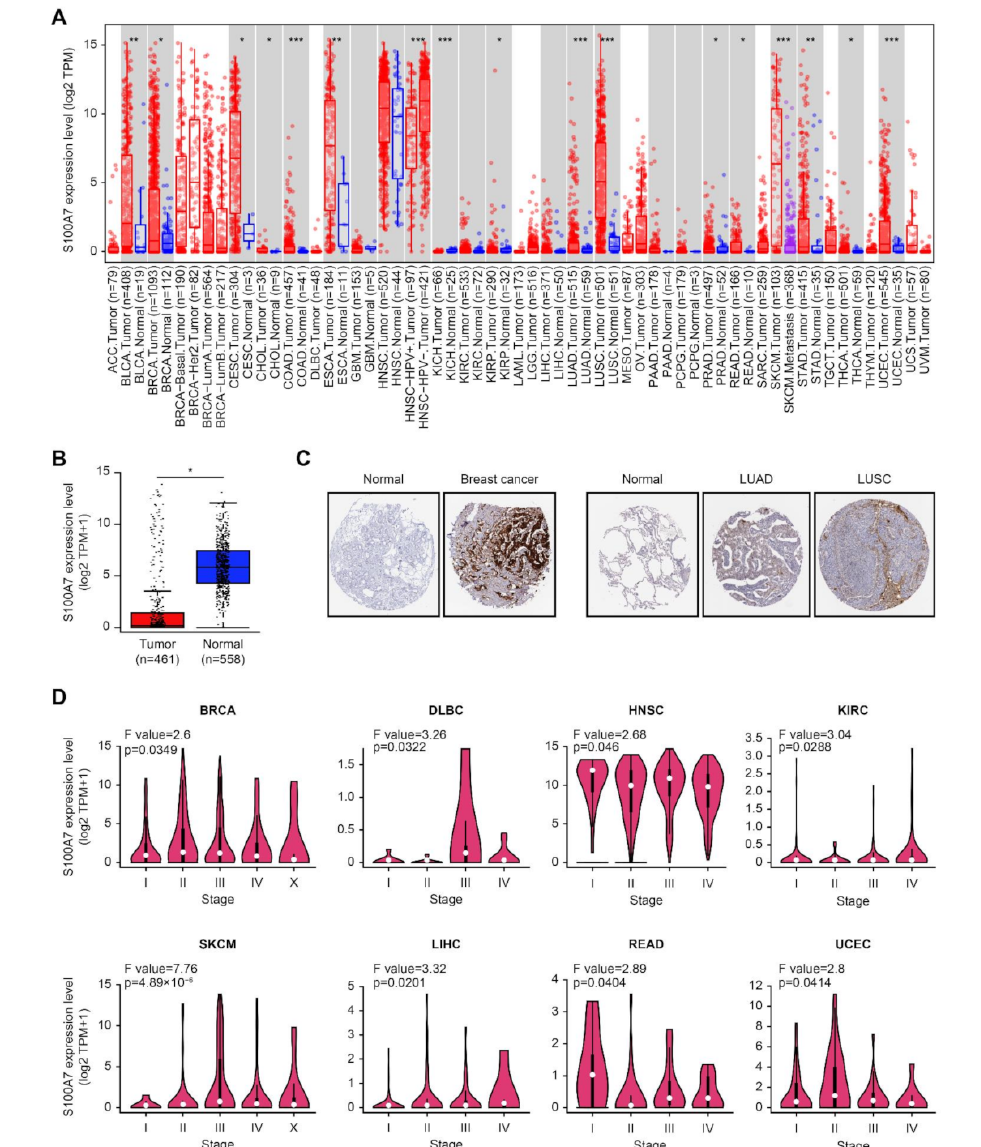
Figure 1. Expression level of the S100A7 gene in different tumors and pathological stages. ( A ) The gene expression levels of S100A7 in different cancers or specific cancer subtypes. * p < 0.05; ** p <